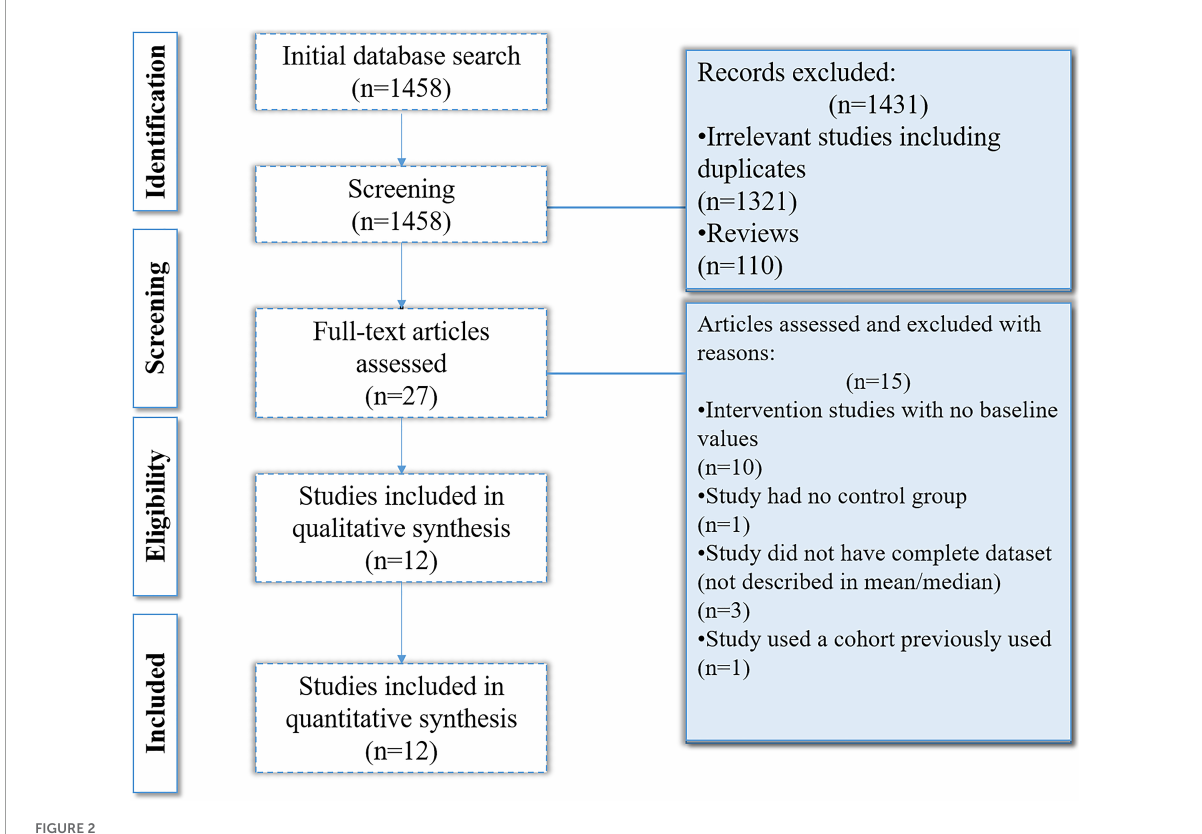
FIGURE2 Flowchart of the selection